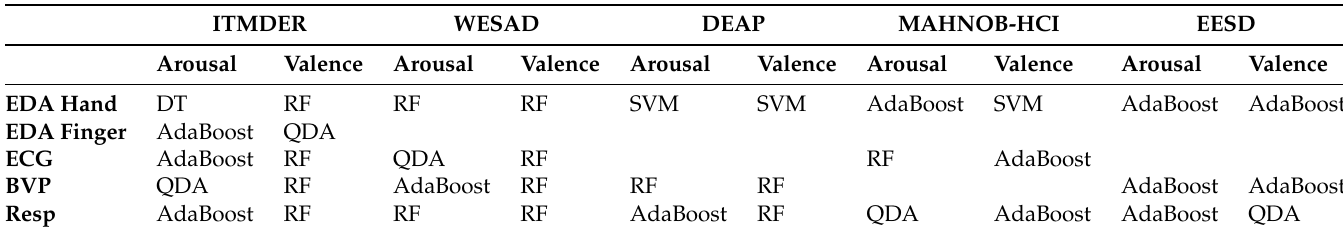
Table 3. Classifier used per dataset and sensor modality for the Arousal and Valence dimensions respectively used in the SL and DF methodologies, obtained using 4-fold CV. Nomenclature: K-Nearest Neighbour (k-NN); Decision Tree (DT); Random Forest (RF); Support Vector Machines (SVM); Gaussian Naive Bayes (GNB); and Quadratic Discriminant Analysis